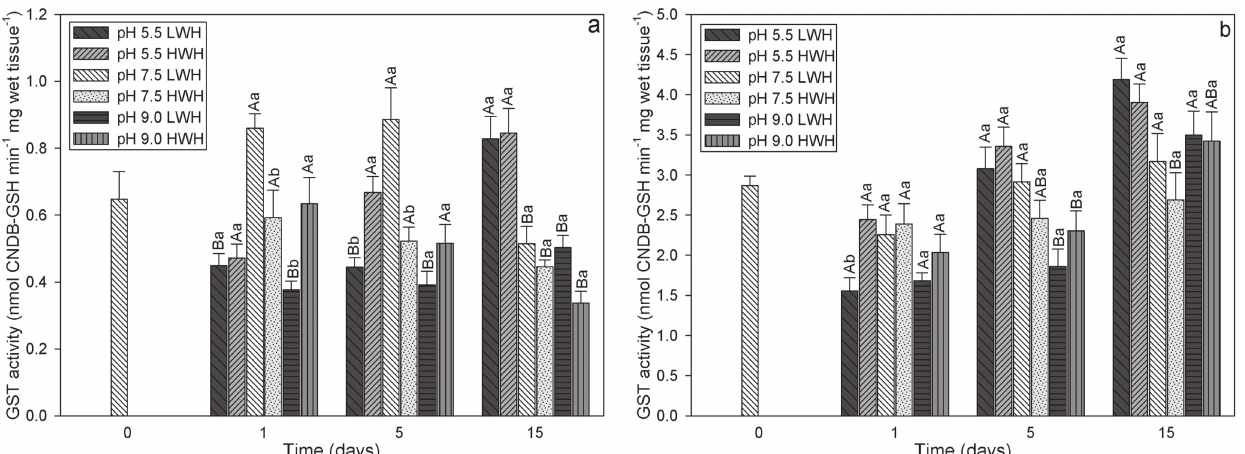
Fig. 1. Glutathione-S-transferase (GST) activity (nmol CNDB-GSH min -1 mg wet tissue -1 ) in a. gills and b. kidney of pacu ( Piaractus mesopotamicus ) juveniles under different water hardness and pH at different times. LWH = low water hardness (50 mg CaCO L -1 ); HWH = high water hardness (120 mg CaCO L -1 ). Data are presented as the means ± SEM (n = 9 fish 3 3 treatment –1 ). Different uppercase letters indicate statistically significant differences between pH at the same hardness (P < 0.05). Different lowercase letters indicate statistically differences between hardness at the same pH (P <